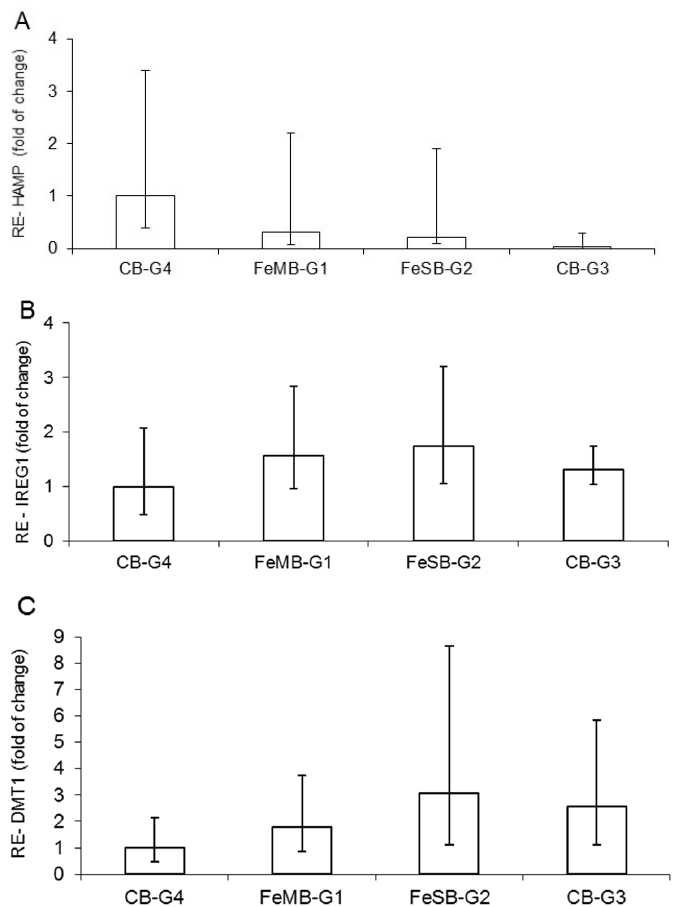
Figure 1. Effect of different breads on relative expression (RE) of hepcidin (HAMP) mRNA in liver ( A ); ferroportin (IREG1) ( B ); and Fe importer divalent metal transporter 1 (DMT1) mRNA in duodenum ( C ) determined by qPCR. Data are expressed as fold changes with respect to CB-G4. FeMB-G1: no iron supplementation/Microencapsulated Fe Fortified bread; FeSB-G2: no iron supplementation/Free Fe Fortified bread; CB-G3: no iron supplementation/control bread; CB-G4: iron supplementation/control bread.